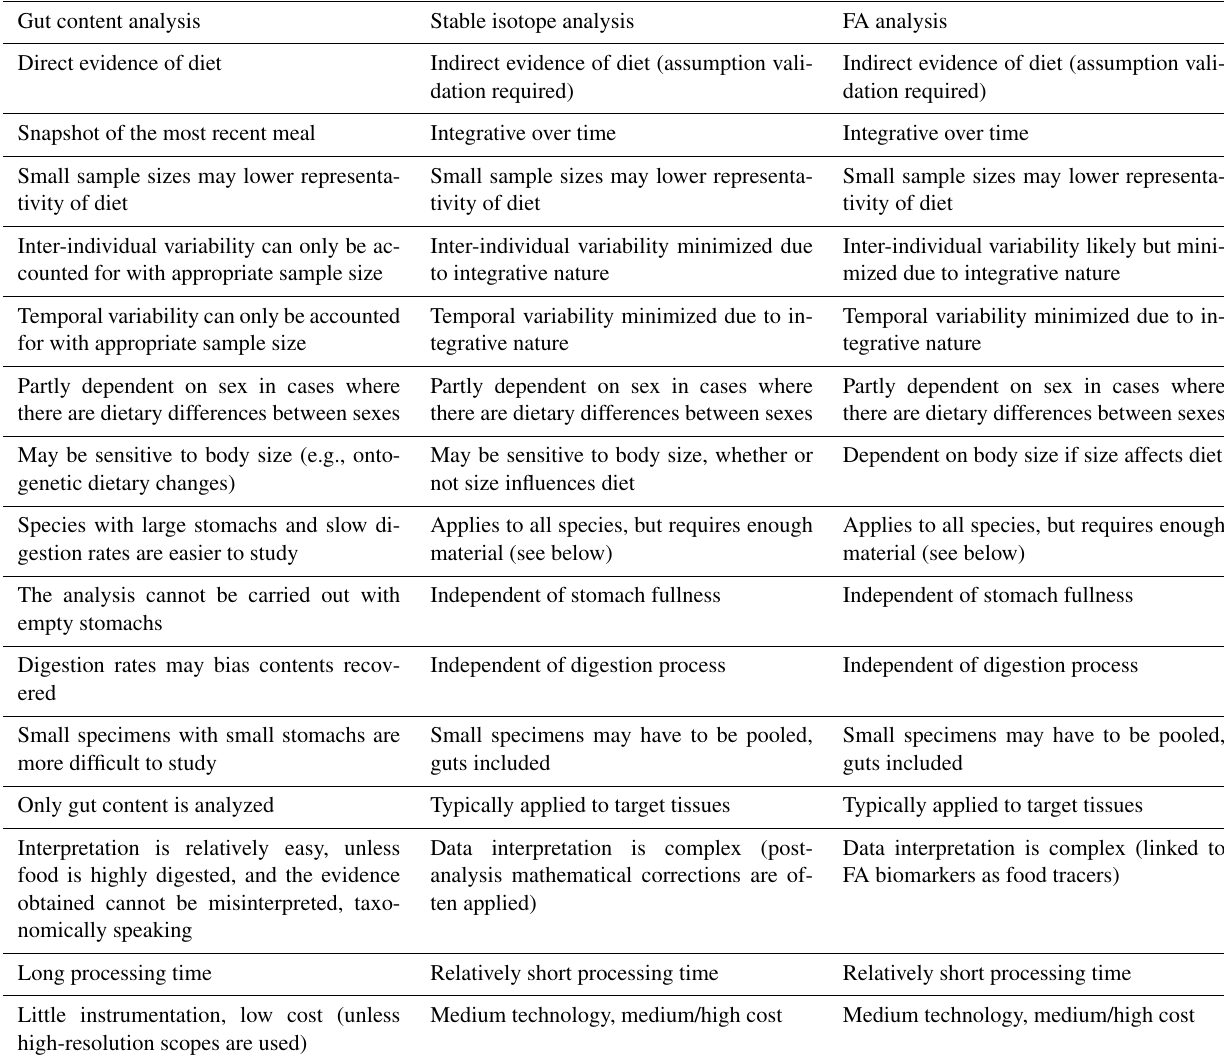
Table 1. Comparison outlining the major strengths and drawbacks of gut content, stable isotope, and FA analysis. Gut content analysis Stable isotope analysis FA analysis Indirect evidence of diet (assumption vali- Indirect evidence of diet (assumption